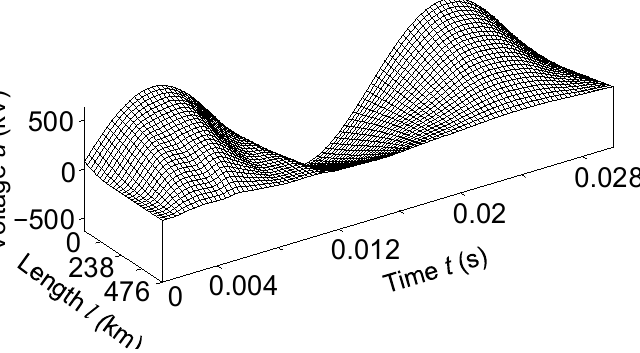
∈ ∈ (0; 0.03) s. (0; 0.03) s.